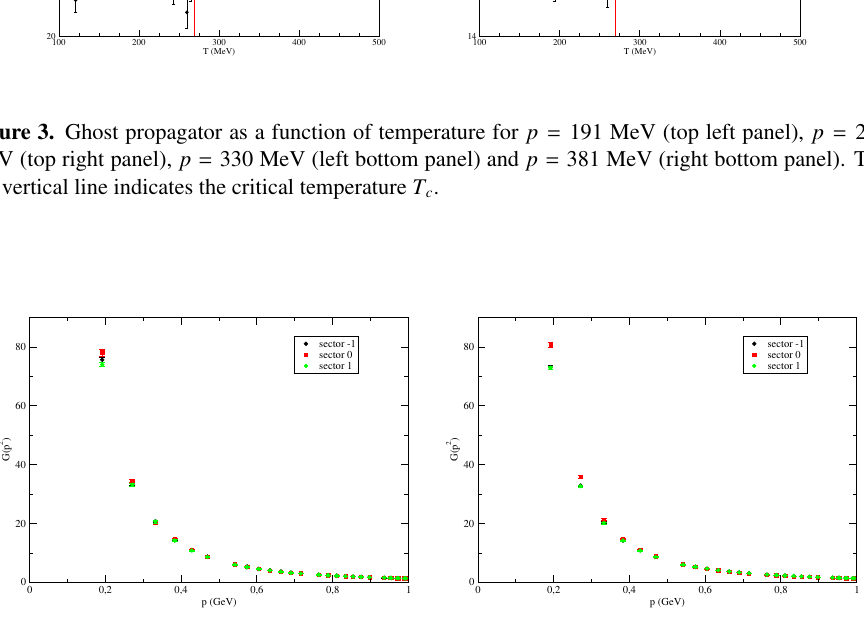
Figure 4. Ghost propagator’s sector dependence below T c (left-hand panel at T = 270 MeV) and above T c (right-hand panel at T = 274